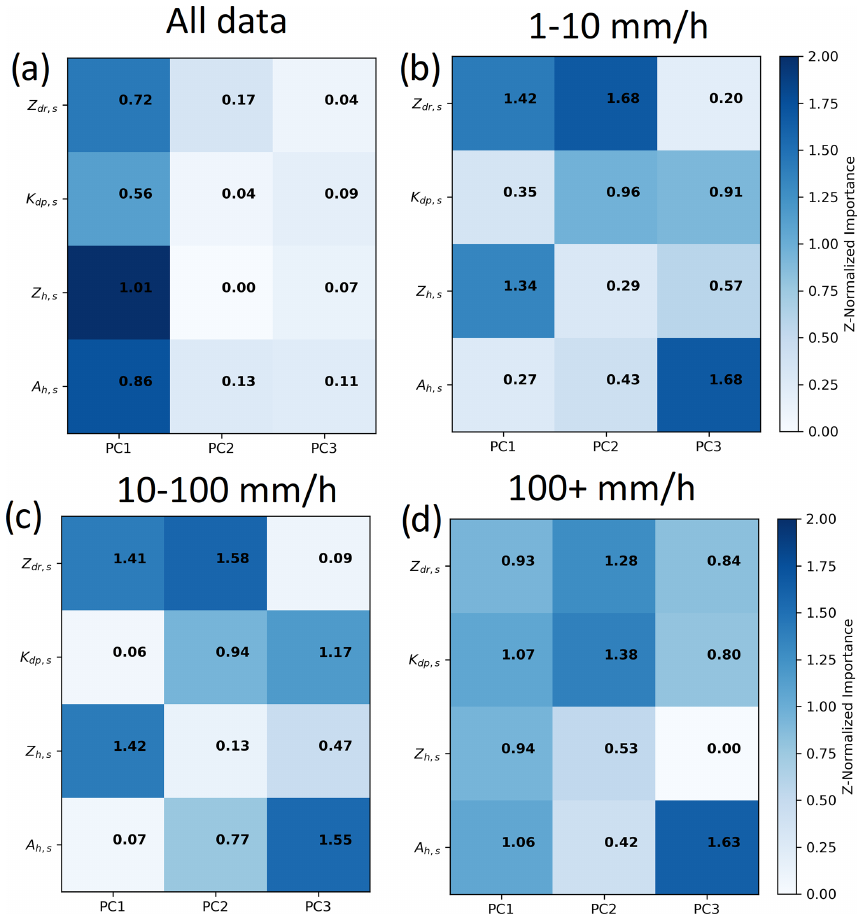
Figure 7. As Fig. 6 but for the